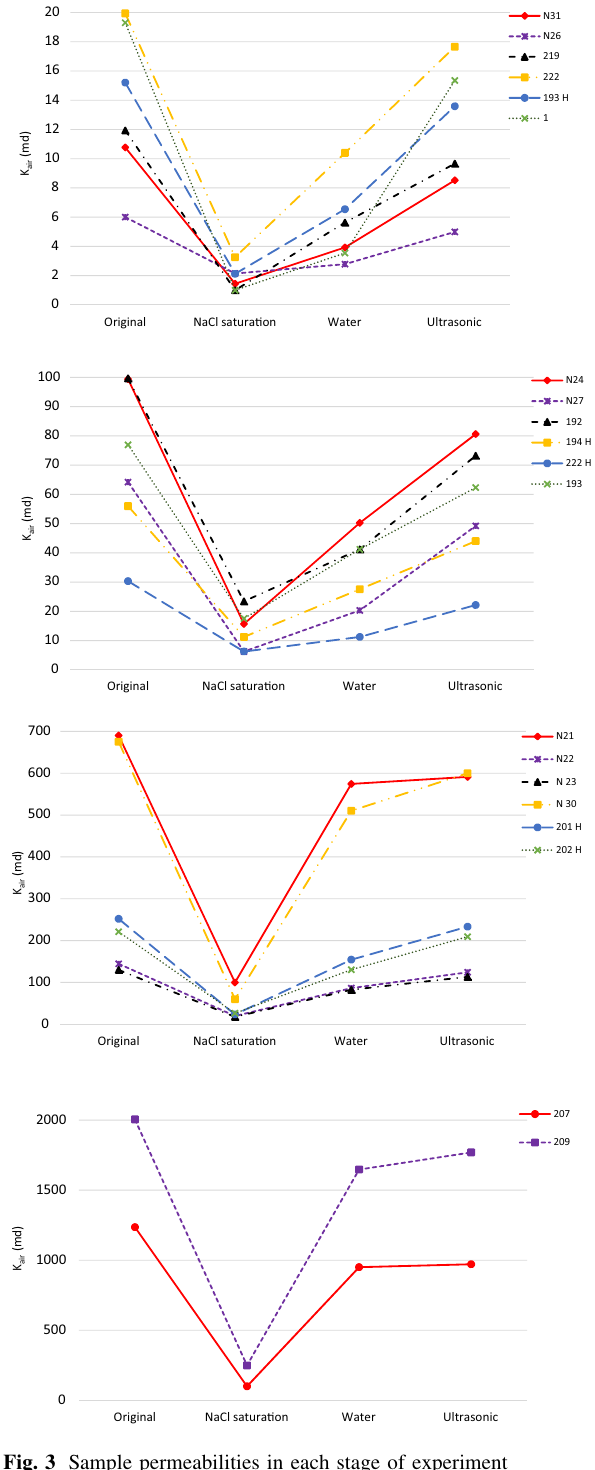
Fig. 3 Sample permeabilities in each stage of